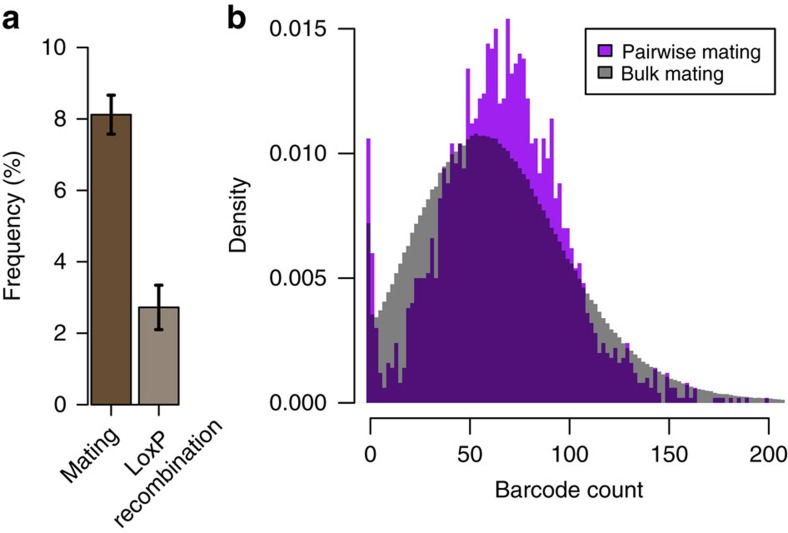
PPiSeq is scalable.(a) Lower bounds of the mating and loxP recombination efficiencies of a pooled mating and recombination protocol that uses ∼1010 cells per standard plate. Error bars are s.e.m. Each plate has the potential to generate >2 × 107 double barcodes. (b) Density plot of the frequencies of ∼106 double barcodes that were generated by bulk mating (grey) and 2,500 double barcodes that were generated by pairwise mating (purple). In both cases, the average number of reads per barcode is 67.